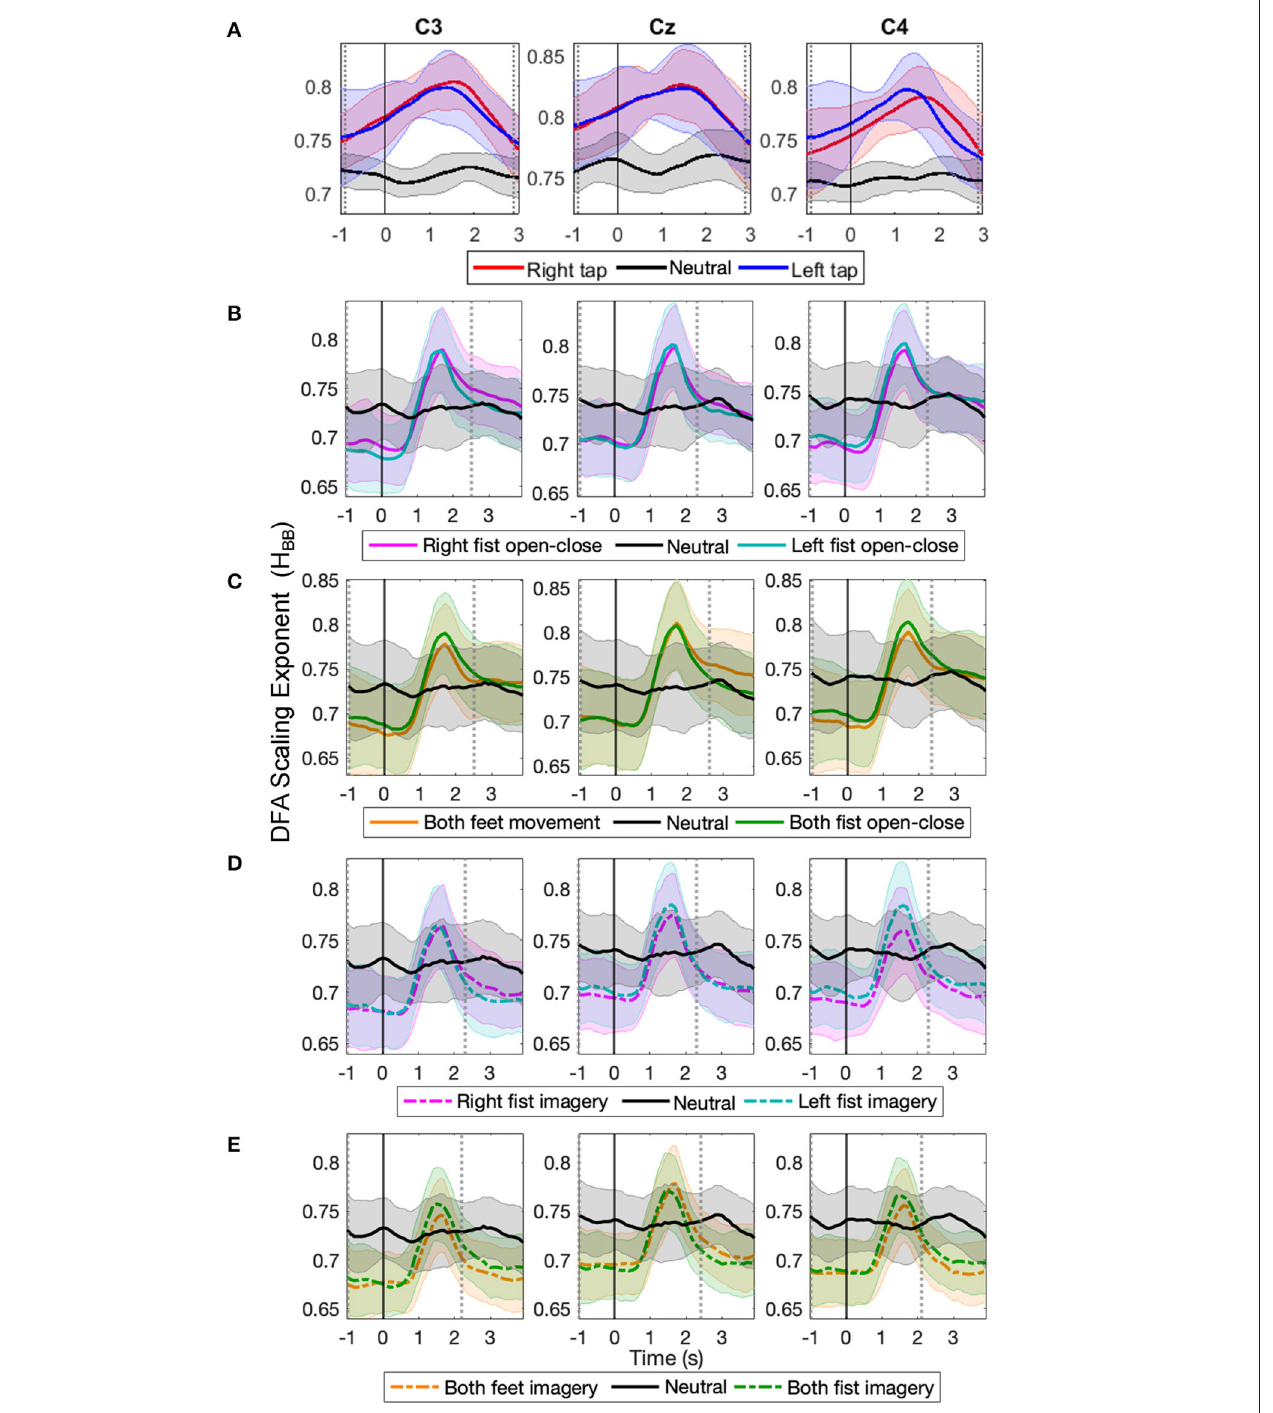
FIGURE 2 | The time evolution of grand average detrended fluctuation analysis (DFA) scaling exponents of broadband electroencephalography (EEG) ( H BB ) in C3, Cz, and C4 during different movement and motor imagery tasks. The progression of the grand average of mean H BB of all participants during (A) single asynchronous right (red) and left (blue) finger tap and resting state (black), (B) continuous right (magenta) and left (cyan) fist open-close movement, (C) continuous both feet (orange) and both fist (green) open-close movement, (D) motor imagery of continuous right (dashed magenta) and left (dashed cyan) fist open-close, (E) motor imagery of continuous both feet (dashed orange) and both fist (dashed green) open-close. Shaded areas show the standard deviation. Solid vertical line at 0 s marks finger tap onset in (A) and motor task cue in (B–E) . Dotted gray vertical lines show the period in which H BB of motor task trials is significantly different ( p < 0.05, Mann–Whitney U -test) from that of resting state trials. The H BB shows clear increase during all motor tasks.